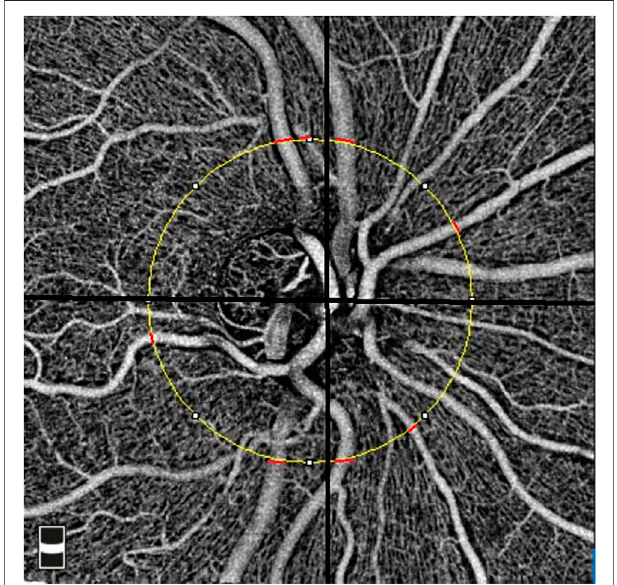
FIGURE 2 | Measurement of the peripapillary vessel caliber in the 4.5 × 4.5 mm optical coherence tomography angiography image. The yellow circle represents a 3.4-mm circle centered on the disc. The location of the measurements was shown using red lines for peripapillary quadrants.